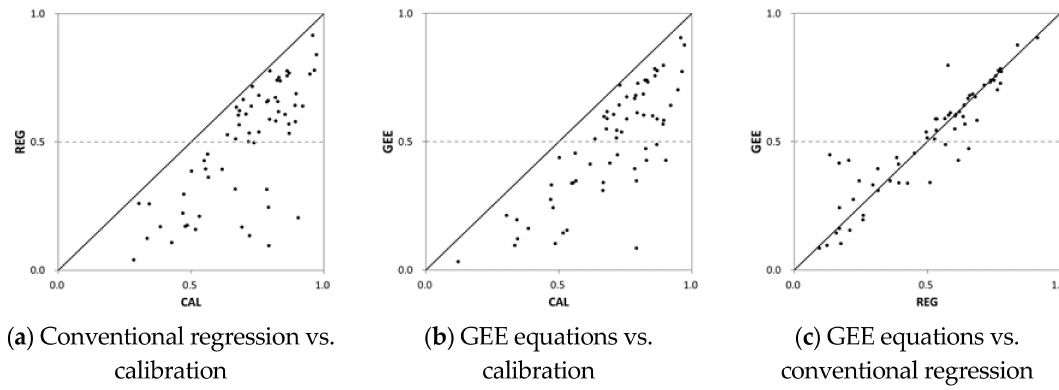
Figure 8. Comparison between the NSE values obtained using calibration, conventional regression and